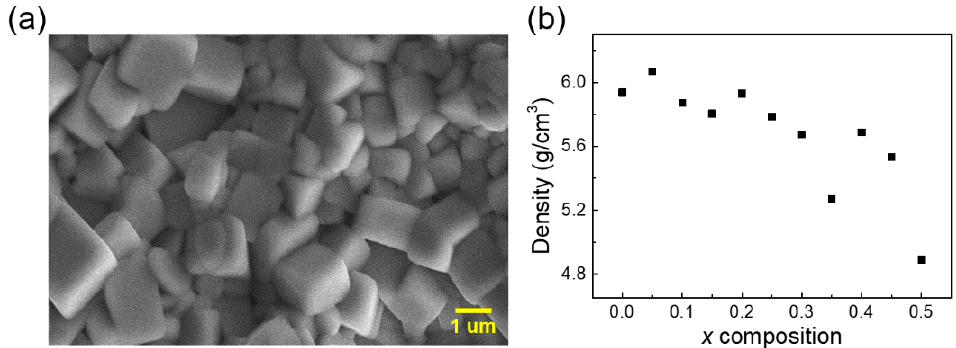
Figure 2. ( a ) Surface morphology at x = 0.10 and ( b ) the apparent density change with x composition of (Bi 0.5 Na 0.5- x K x )TiO 3 (BNKT) of (Bi 0.5 Na 0.5- x K x )TiO 3 (BNKT) ceramics.